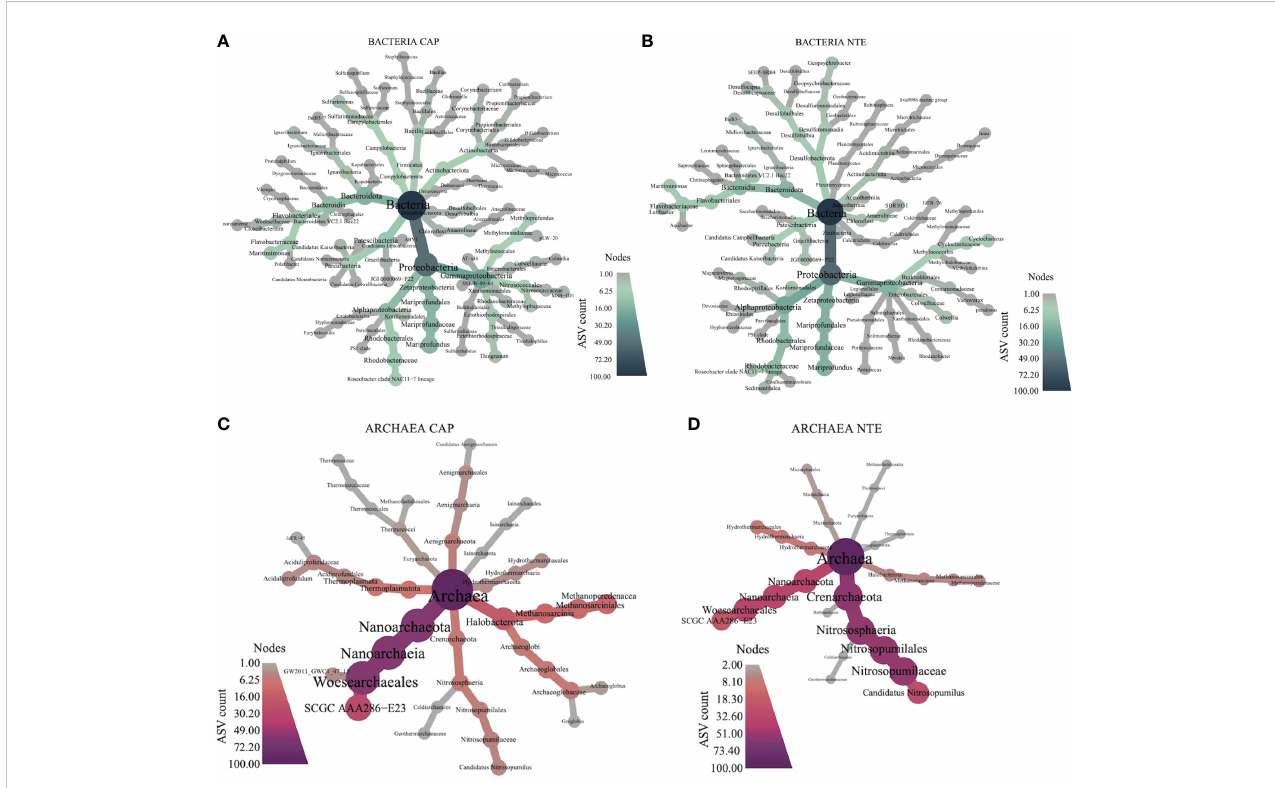
FIGURE 5 Heat trees depicting the sum of bacterial ASVs counts per-taxon of (A) Capelinhos and (B) North Tour Eiffel, and the sum of archaeal ASVs counts per- taxon of (C) Capelinhos and (D) North Tour Eiffel. The size and color of the nodes of each cladogram show the number of taxa identi fi ed at that taxonomic